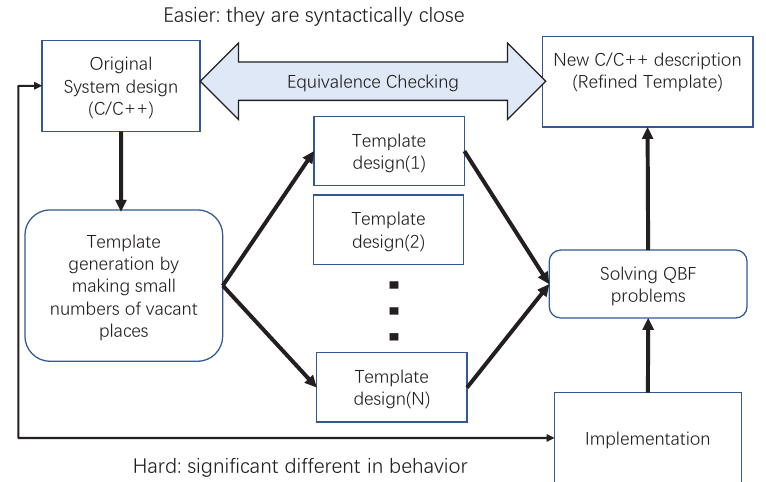
Figure 5. The flow of the proposed equivalence checking